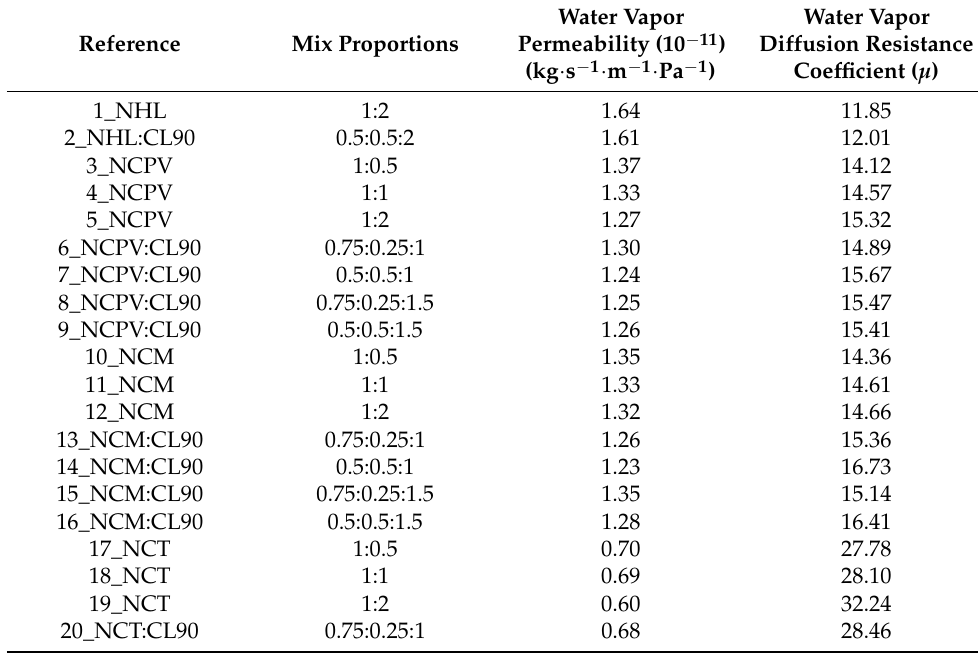
Table 7. Water vapor permeability and resistance coefficient of mortars at 28 days of